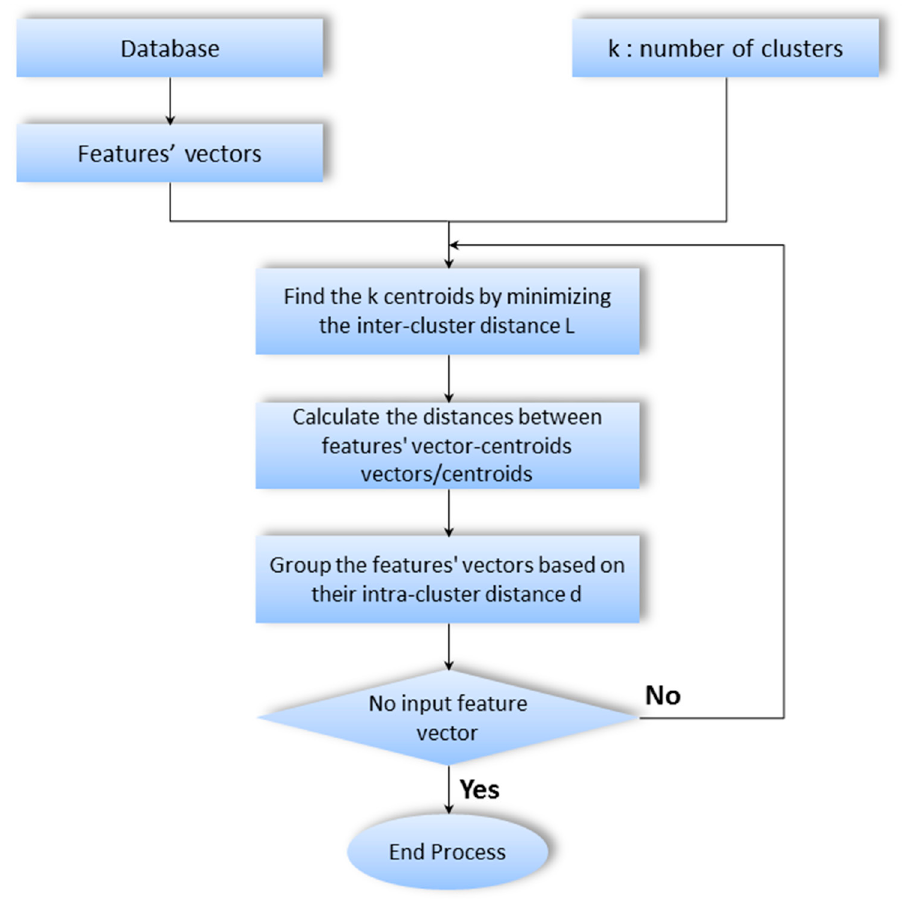
Figure 3. The k-means clustering algorithm.